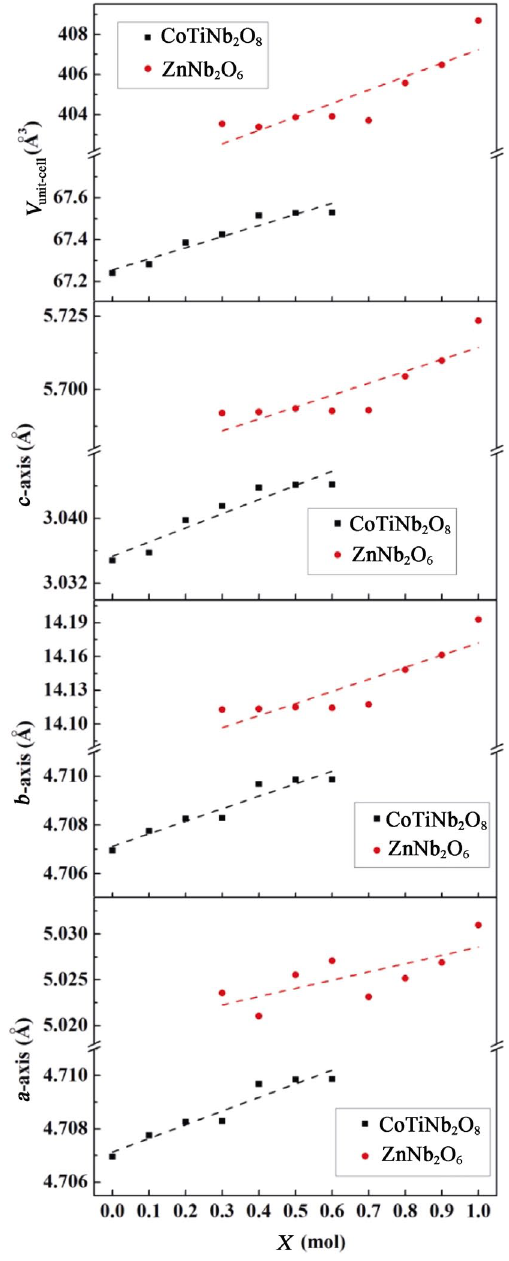
Fig. 2 Lattice parameters and unit-cell volume of (1 − x )CoTiNb 2 O 8 − x ZnNb 2 O 6 ceramics. Due to the difference in the polyhedron structure, the O and CoTiNb O chemical reaction between ZnNb 2 6 2 8 was inhibited. The good chemical compatibility of O and CoTiNb O contributed to the successful ZnNb 2 6 2 8 compensation of dielectric properties, especially for τ f